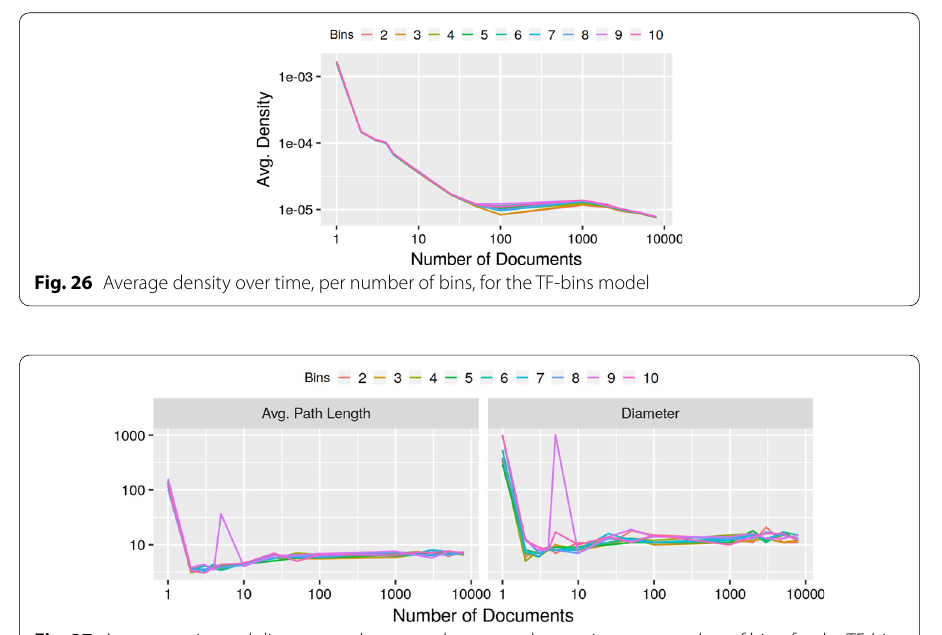
Fig. 27 Average estimated diameter and average shortest path over time, per number of bins, for the TF-bins